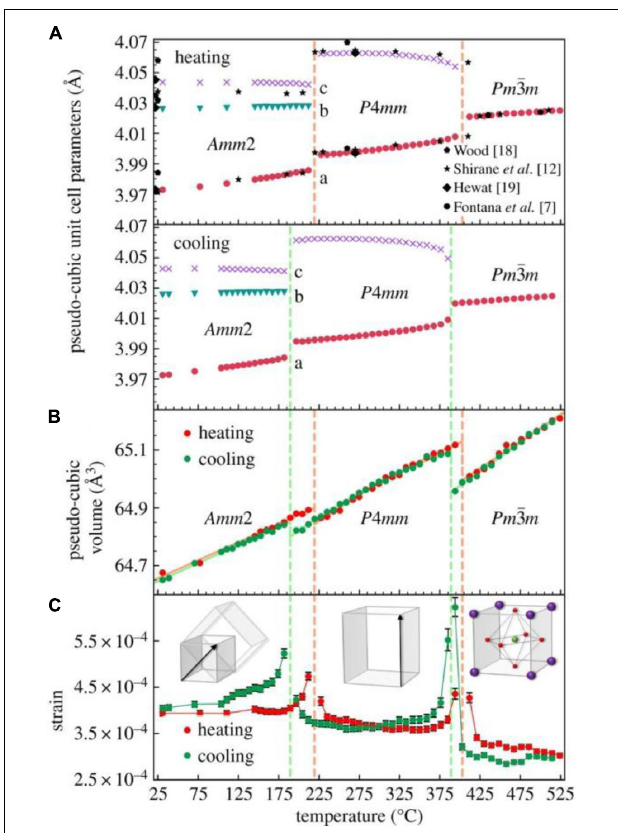
FIGURE 4 | Pseudo-cubic (A) unit cell parameters and (B) unit cell volume of KNbO 3 upon heating and cooling measured in situ X-ray diffraction. Previous published data by Wood [18], Shirane et al. [12], Hewat [19] and Fontana et al. [7] are shown for comparison [references in Skjaervø et al. (2018)]. (C) The refined strain (Reproduced from https://doi.org/10.1098/rsos.180368,